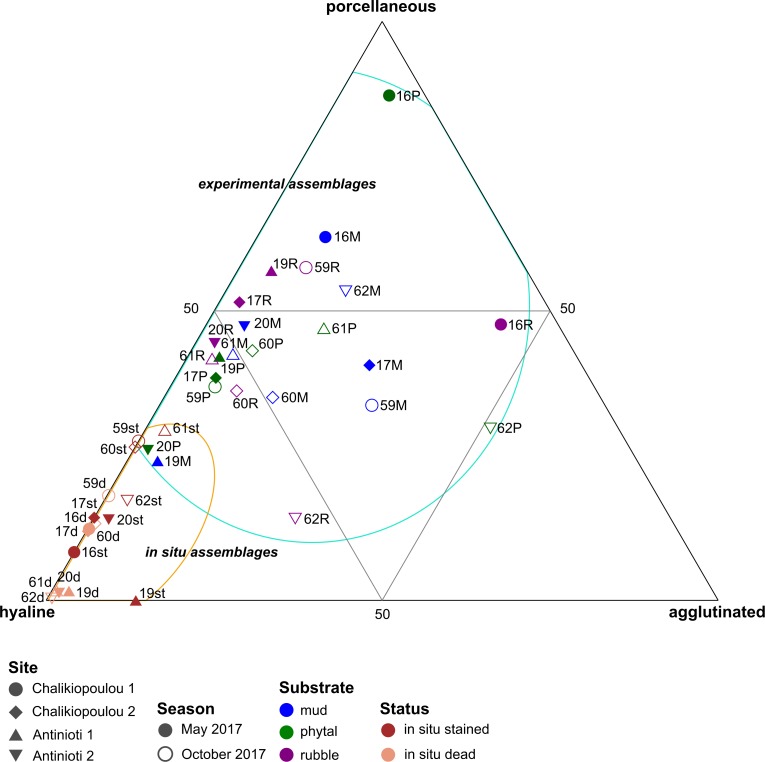
Ternary plot depicting the distribution of foraminiferal shell types within in situ and experimental assemblages (combined replicates).Note that in situ assemblages are distinguished as stained (living) and dead assemblages.